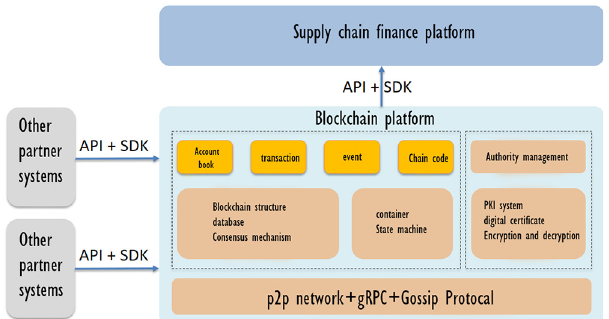
Figure 2. Integrated architecture diagram of blockchain and supply chain fi nancial